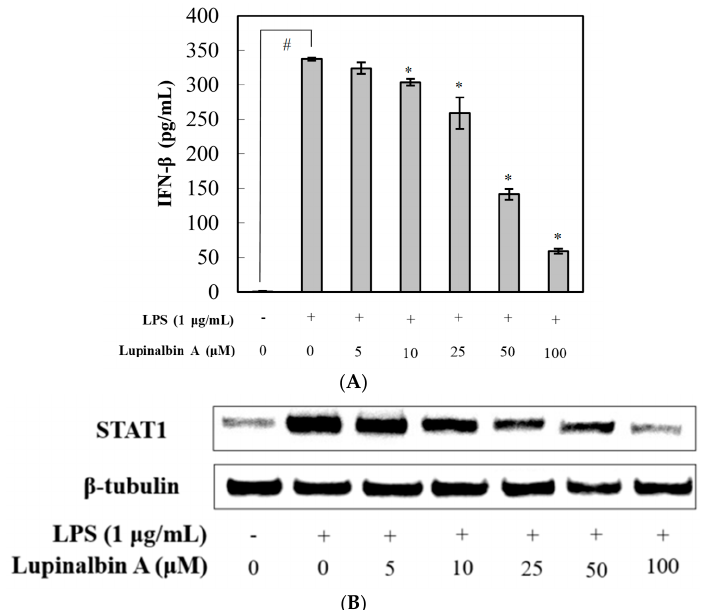
Figure 5. Effect of lupinalbin A on IFN- β production and STAT1 protein in LPS-treated RAW264.7 cells. ( A ) Cells were treated with various concentrations of lupinalbin A (5–100 µM) for 2 h and then stimulated with LPS (1 µg/mL) for 18 h. IFN- β production was determined by ELISA. The data are presented as mean ± SDs ( n = 3). # p < 0.05 vs. control group, * p < 0.05 vs. LPS-treated group; ( B ) STAT1 protein levels were measured by western blot analysis.